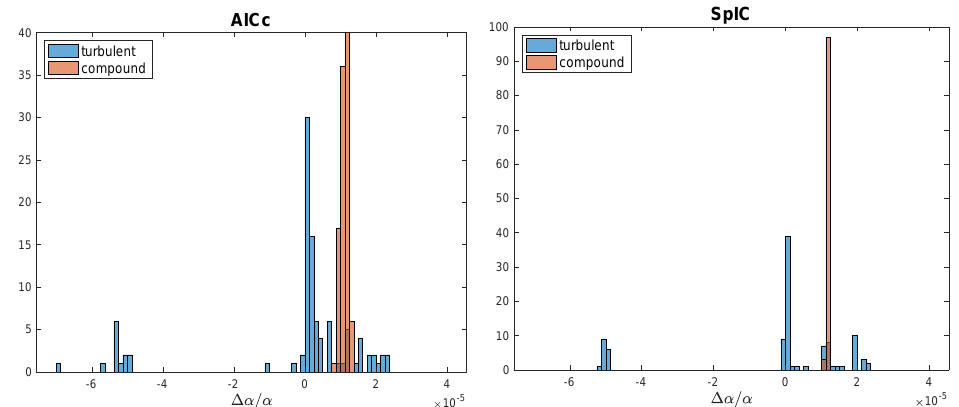
Figure 4. Results from calculations simulating the impact of “blinding” on measurements of ∆ α / α . The red bars show the results from fitting compound broadened models without using distortion blinding. Those results are correct and unbiased. The blue bars show the results from fitting turbulent broadened models and using distortion blinding. The results are stongly biased and the correct ∆ α / α is not recovered. See Section 4.2.